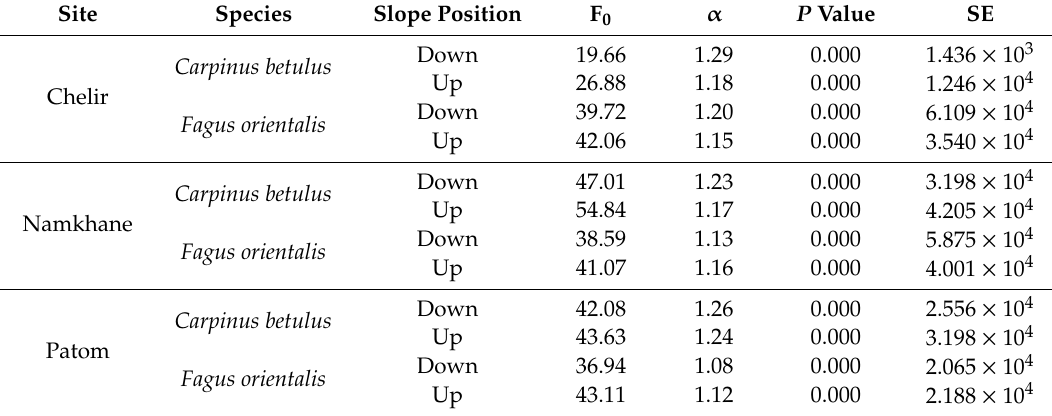
Figure 6. Tensile force at failure point versus root diameter for upslope (red circles) and downslope (blue circles) positions relative to the tree stem at three sites for Carpinus betulus and Fagus orientalis . Solid (downslope) and dashed (upslope) lines show power-law regression curves fitted to the data. Table 5. Coefficients and statistical parameters of the power-law regressions for tensile force–root diameter based on a comparison of upslope versus downslope position.